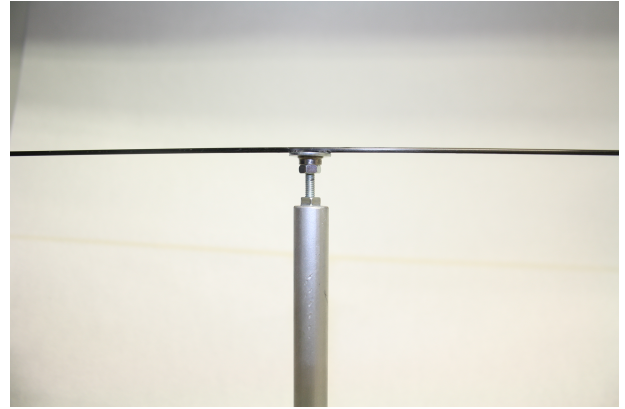
Figure 5. Arm assembly in the endless screw supported by the upper nut.